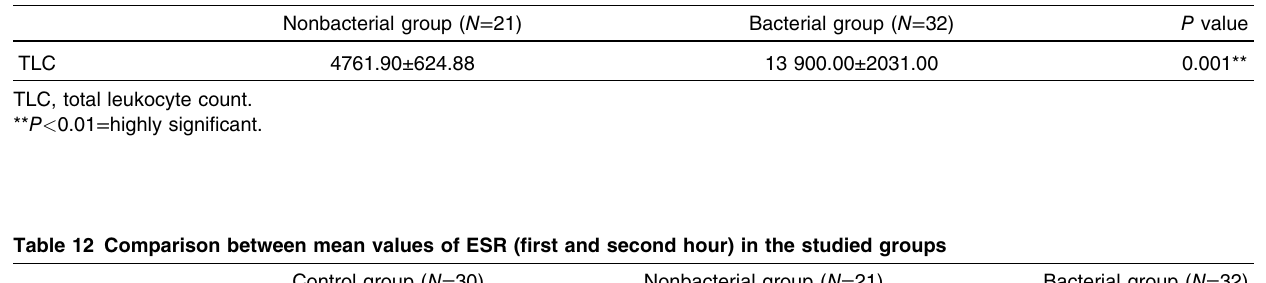
Table 12 Comparison between mean values of ESR (first and second hour) in the studied groups Control group ( N = 30) Nonbacterial group ( N = 21) Bacterial group ( N = 32) First hour